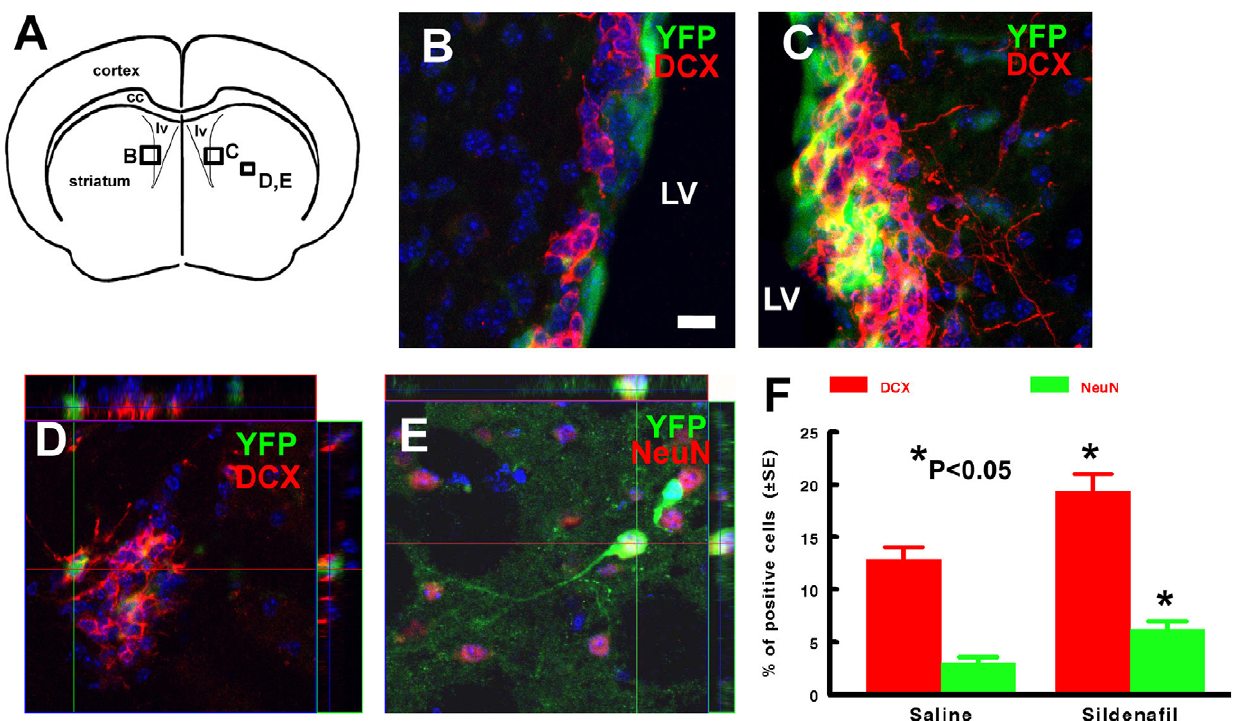
Figure 2. Letters adjacent to boxed areas in schematic representation of a brain coronal section (A) indicate areas where representative confocal microscopic images were taken. Panels B and C show YFP (green) and DCX (red) positive cells in non-ischemic (B) and ischemic SVZ (C) in middle-aged mice 30 days after stroke. Orthogonal views (D, E) show that a YFP immunoreactive cell (green) was DCX positive (D, red) or NeuN (NN) positive (E) in the ischemic striatum. Quantitative data analysis (F) shows percentage of YFP/DCX and YFP/NeuN positive cells in the ischemic striatum after treatment with saline and Sildenafil. *p , 0.05 vs the saline group. n=10/saline and n=11/Sildenafil. Bar=10 m m for B to E. Blue color = cell nuclei. CC = corpus callosum, and LV = lateral ventricle.